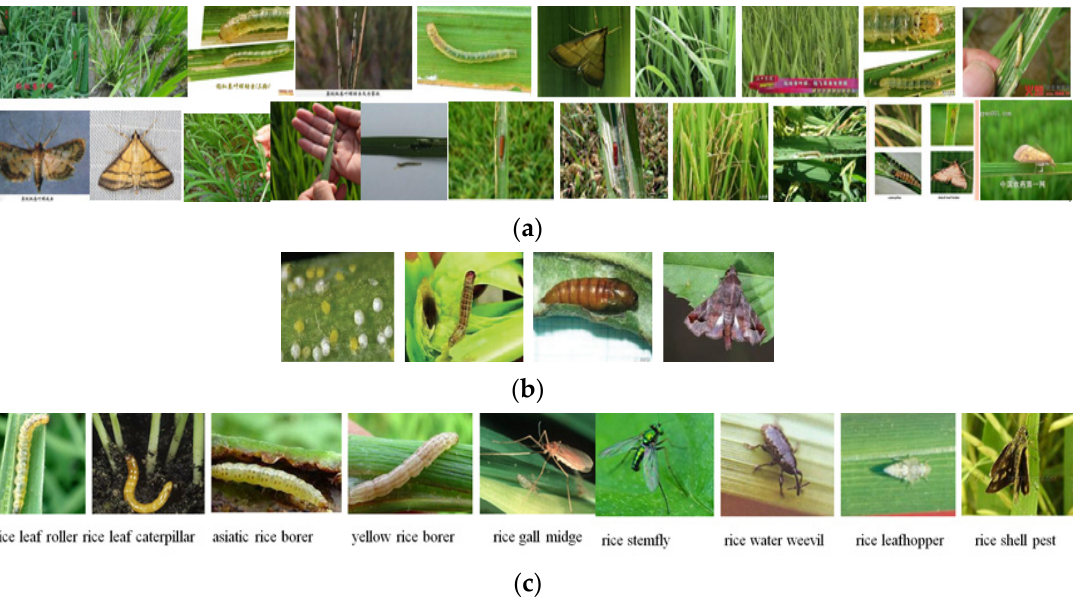
Figure 6. Insect pest image examples in IP102. ( a ) The first 20 original images. ( b ) Different forms of a kind of insect pest at different stages of the life cycle. ( c ) Nine kinds of rice annotated images. IP102 contains 5701 original images of nine rice pests. Their pest image names and corresponding numbers and serial numbers are shown in Table 1, where the maximum number is 1115, and the minimum number is 369. The number of each kind of rice pest image is increased to more than 500 by the augmentation algorithm. All images are converted to JPEG format. Repeated or damaged images are deleted. In this study, all rice insect pest images are used to conduct rice insect pest recognition experiments, where each original image is firstly reshaped to 128 × 128, closer to the actual application, because the sizes of the collected images are not uniform. Finally, 5000 preprocessed images are used for experiments, except for 1034 poor quality or negative images. Table 1. The number of rice pest images in IP102 dataset.